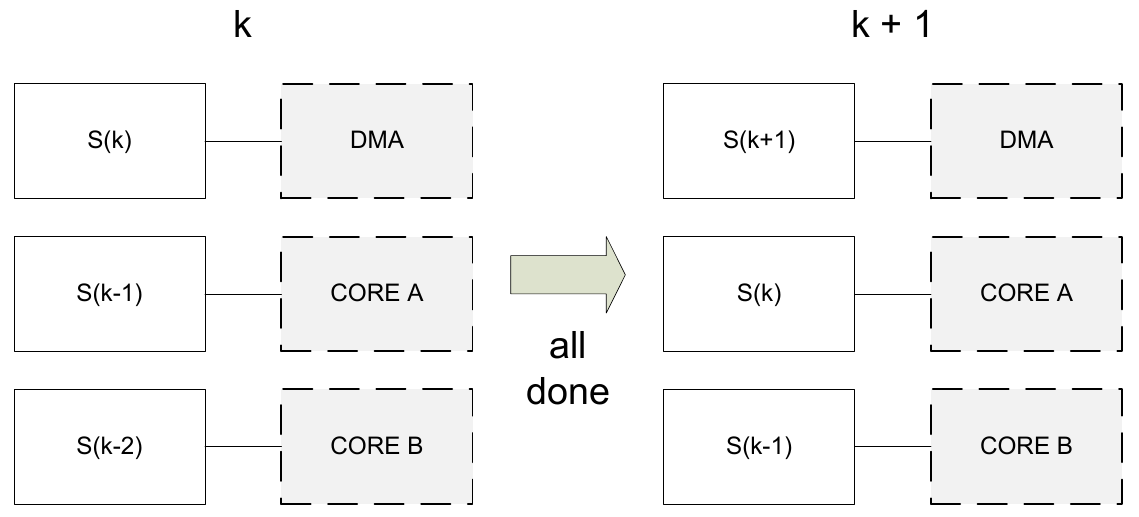
Figure 4. Scene Description Table assignment to processing units on the vision